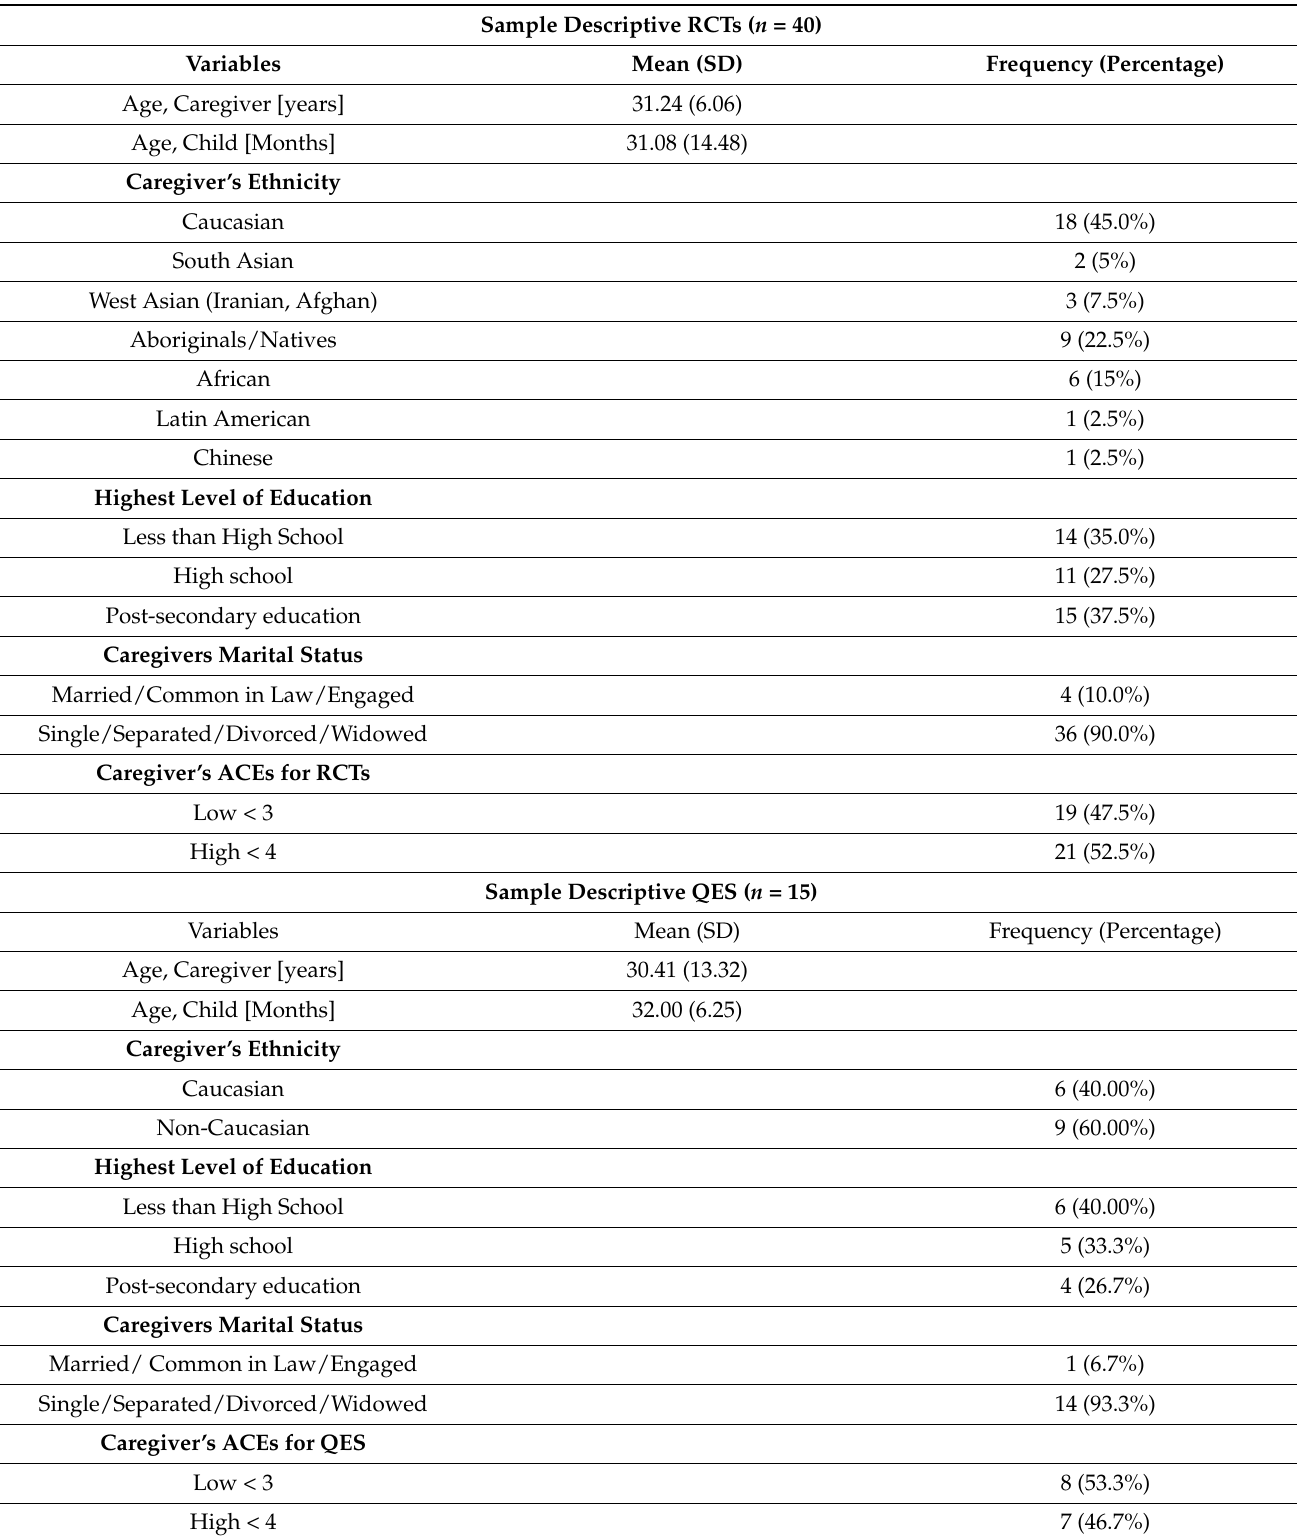
Table 1. Sample descriptive ( n =